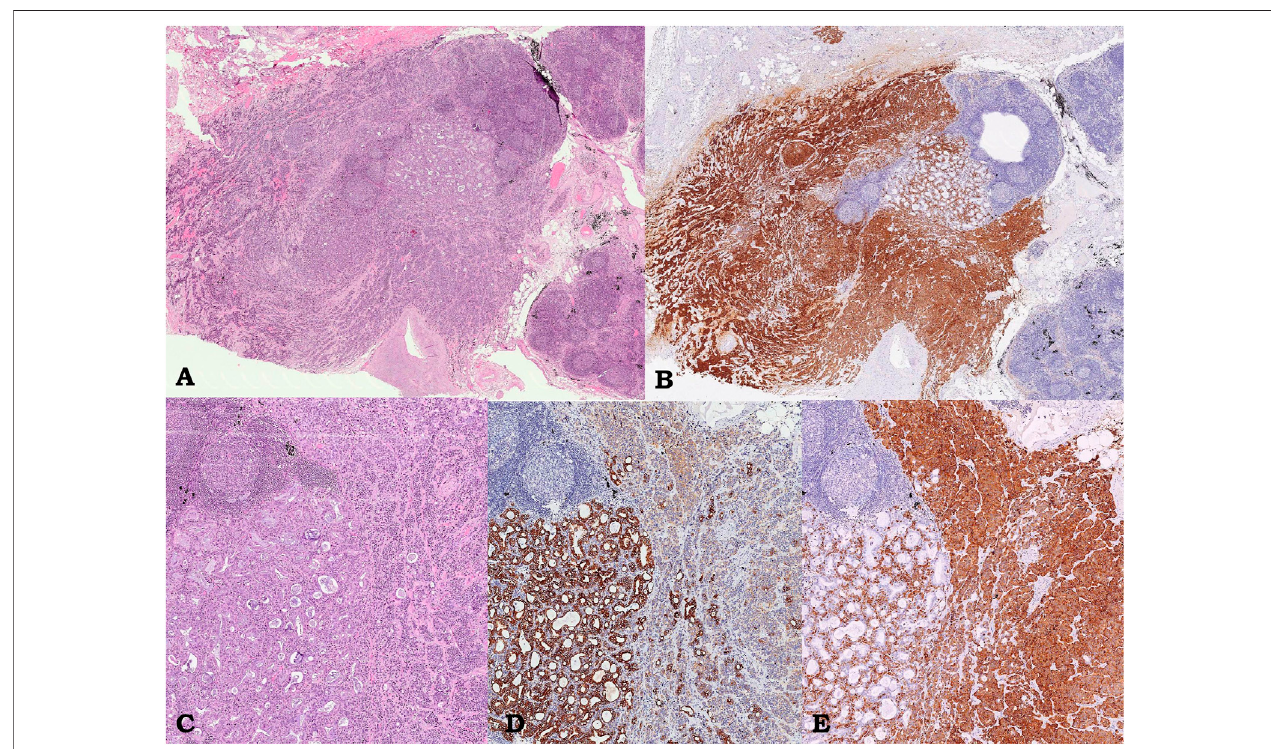
FIGURE 4 | Case 2, lymph node metastasis. Lymph node showing adenocarcinoma component intermingled with carcinoid; hematoxylin/eosin, 3.5 × (A) . Immunostaining showing diffuse and strong immunoreactivity for Synapto fi sin only in the carcinoid component ( on the left, 3.5 × ; B) . At higher power fi eld, composite neoplasm ( hematoxylin/eosin, C , 4 × ) showing diffuse and strong immunoreactivity for CK7 only in the adenocarcinomatous (D , 4 × ) and chromogranin only in the neuroendocrine component (E , 4 × ) ,